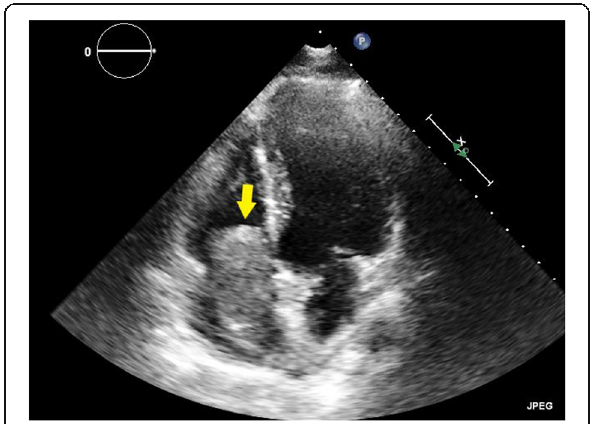
Fig. 2 Transthoracic two-dimensional echocardiography, apical 4 chamber view showing a huge right atrial mass (about 8 × 7 cm), filling the whole cavity of the right atrium